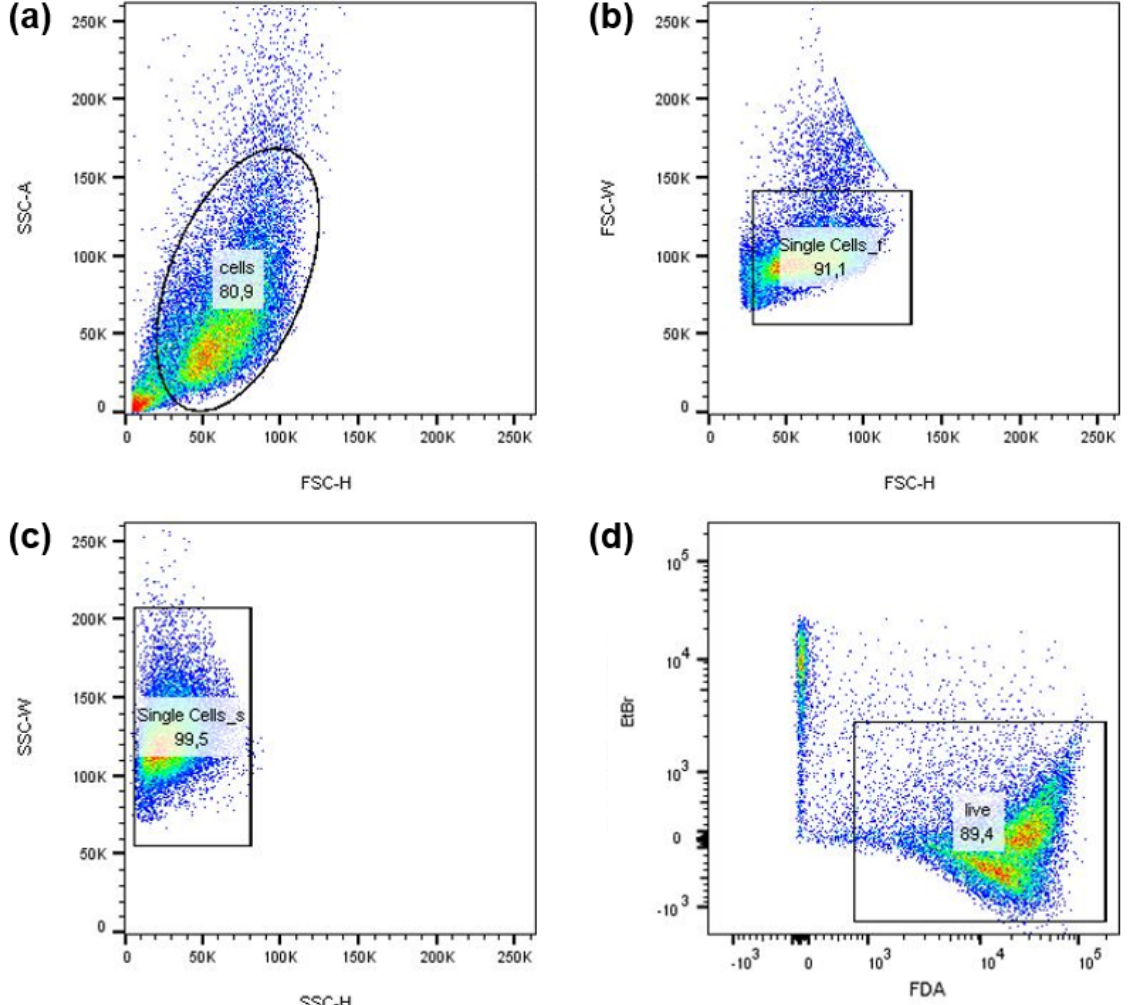
Figure 2. Gating strategy in flow cytometric analyses. The intracellular content of fluorescein-diacetate (FDA) per cell was examined by flow cytometry. Using forward- and side-scatter-parameters, debris ( a ) and doublets ( b , c ) were rejected. Living cells were determined as ethidium bromide (EtBr) negative and FDA positive events ( d ). Abbreviations: side-scatter area, SSC-A; forward-scatter width, FSC-W; forward-scatter height, FSC-H; side-scatter width, SSC-W; side-scatter height,